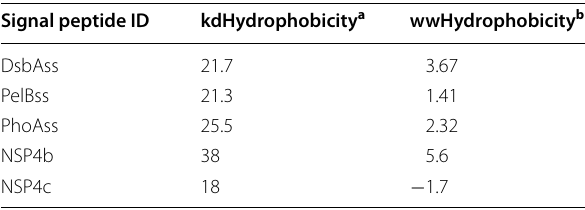
The total hydrophobicity of the h-domain amino acid sequences were calculated according to a Kyte and Doolittle (1982) and b Wimley and White (1996)